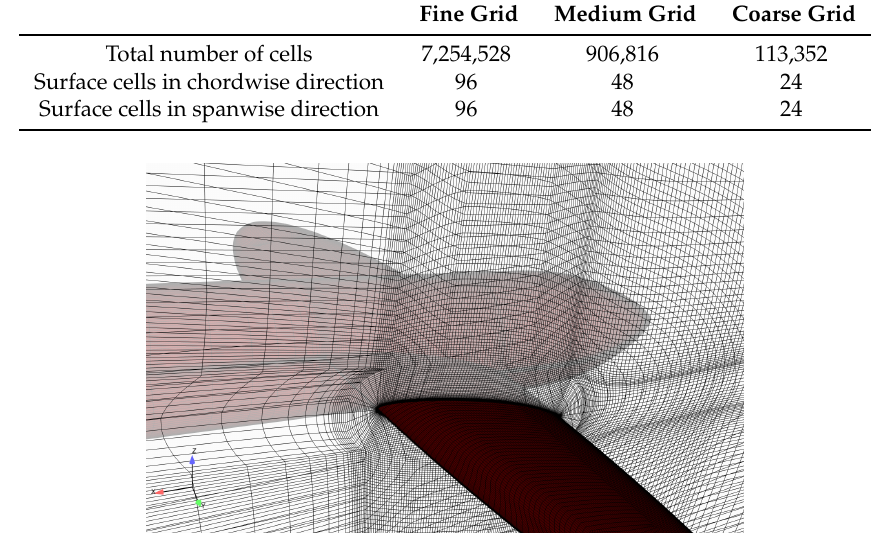
Figure 4. A detail of the grid near the foil.